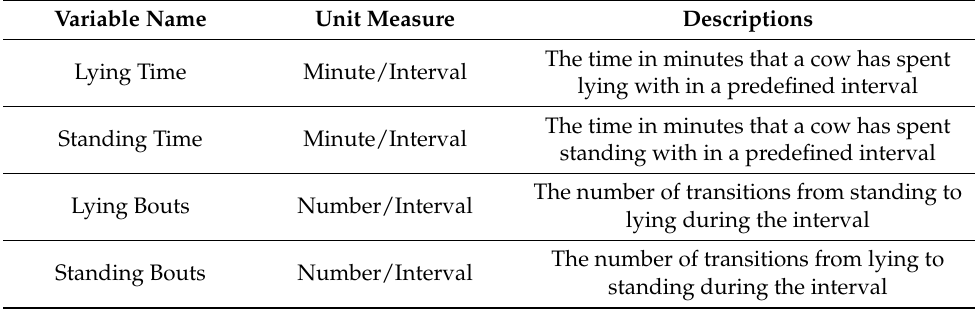
Table 2. Activity variable descriptions.